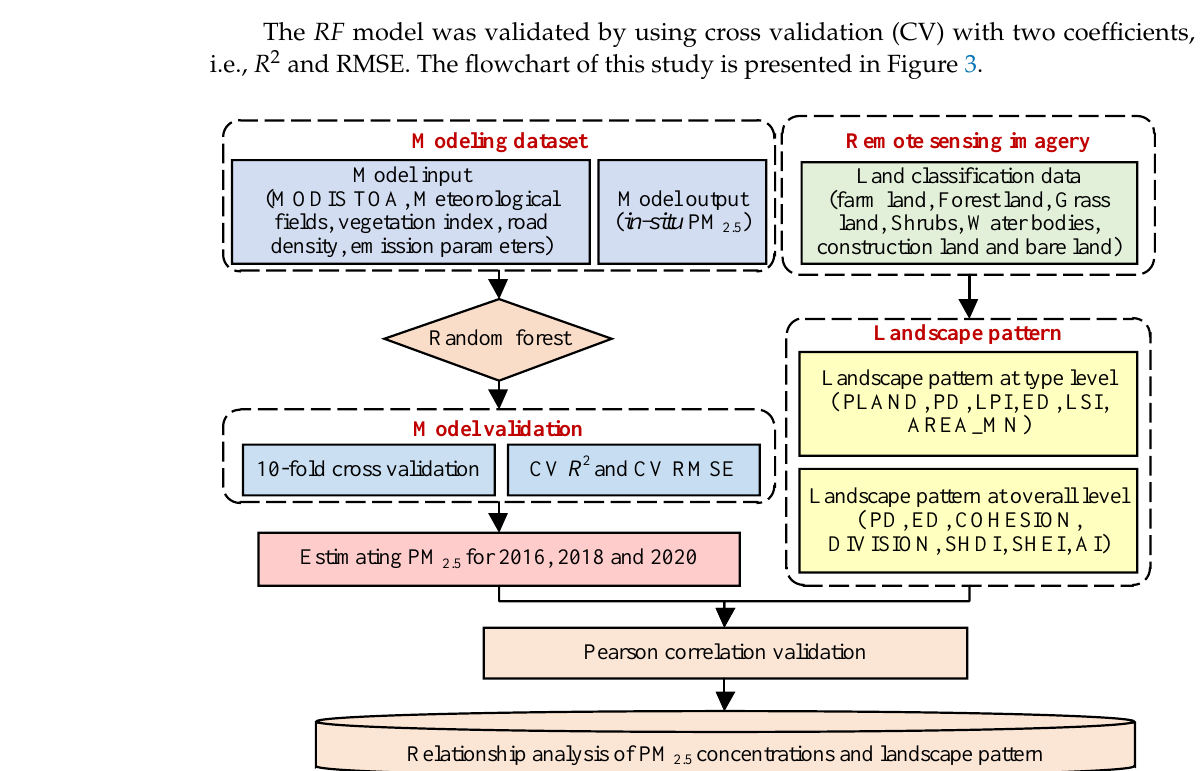
Figure 3. Flowchart of the study.